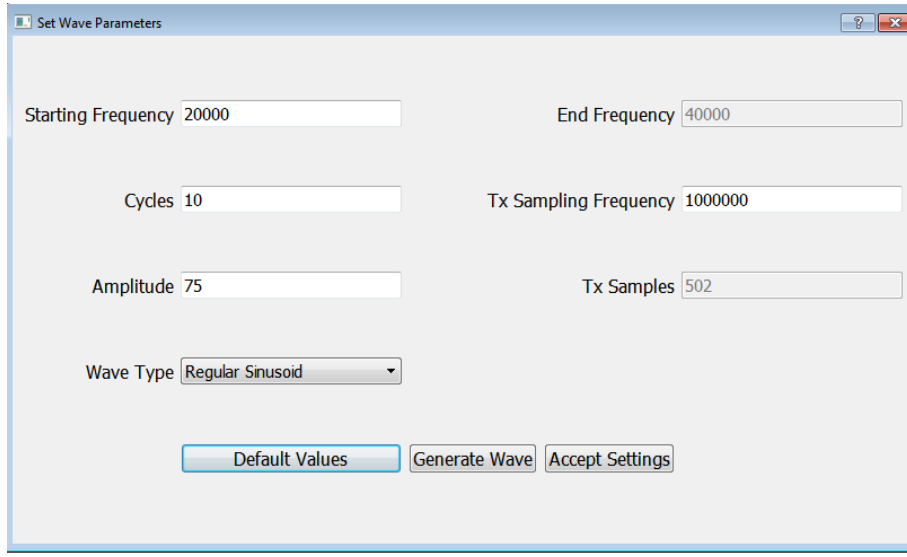
Figure 8. Wave generator—graphical user interface (GUI).